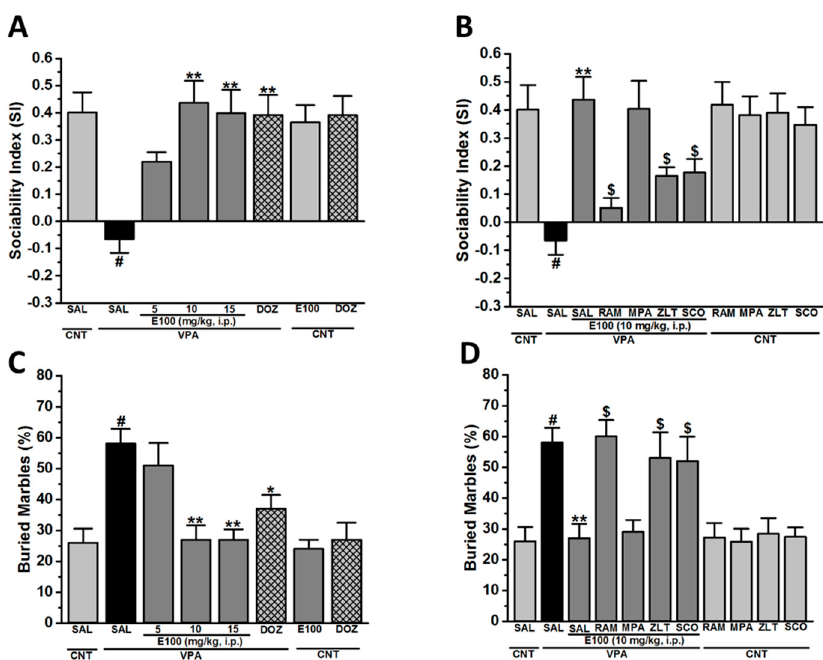
Figure 2. E100 improved sociability in three-chamber behaviour (TCB) and repetitive behavior in marble-burying behaviour (MBB) paradigms. ( A , B ) Following acclimatization for a duration of 10 min, male mice were allowed to explore all three chambers for 10 min. The obtained results were expressed in form of Sociability index (SI). Control (CNT) mice received systemic injections of saline (group 1), E100 (10 mg / kg) (group 7), and donepezil (DOZ) (1 mg / kg) (group 8), whereas VPA mice were injected with saline (group 2), E100 (5, 10, and 15 mg / kg) (groups 3–5), or DOZ (1 mg / kg, i.p.) (group 6) subchronically for 21 days ( A ). Abrogative studies of subchronic (21 days) systemic co-injection of RAM (10 mg / kg, i.p. for group 9), mepyramine (MPA) (10 mg / kg, i.p. group 10), zolantidine (ZLT) (10 mg / kg, i.p., for group 11), or scopolamine (SCO) (0.3 mg / kg, i.p., for group 12) on the E100 (10 mg)-provided improvement of sociability of VPA mice were assessed ( B ). Marble-burying behavior (MBB) was measured after a 30-min testing session applying the same treatments. VPA mice treated with saline (group 2) displayed significantly increased repetitive behaviors when compared to CNT mice (group